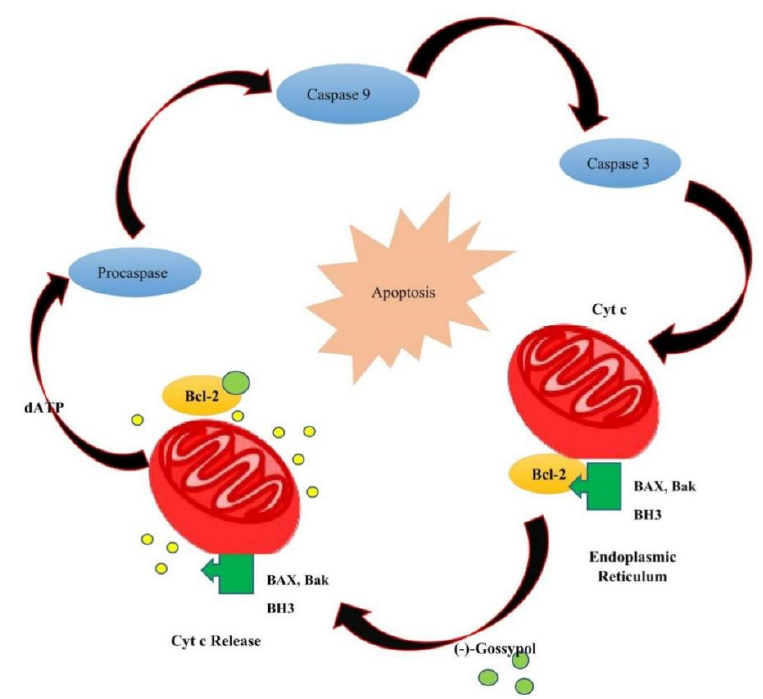
Figure 6. In apoptosis ‐ sensitive cancer cells with low levels of antiapoptotic proteins Bcl ‐ 2 and Bcl ‐ xL, ( − ) ‐ gossypol is known to trigger apoptosis.